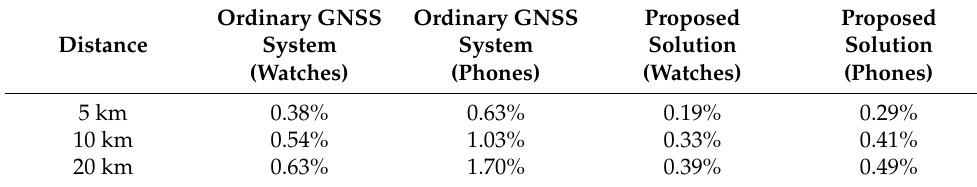
Table 1. Distance accuracy error.